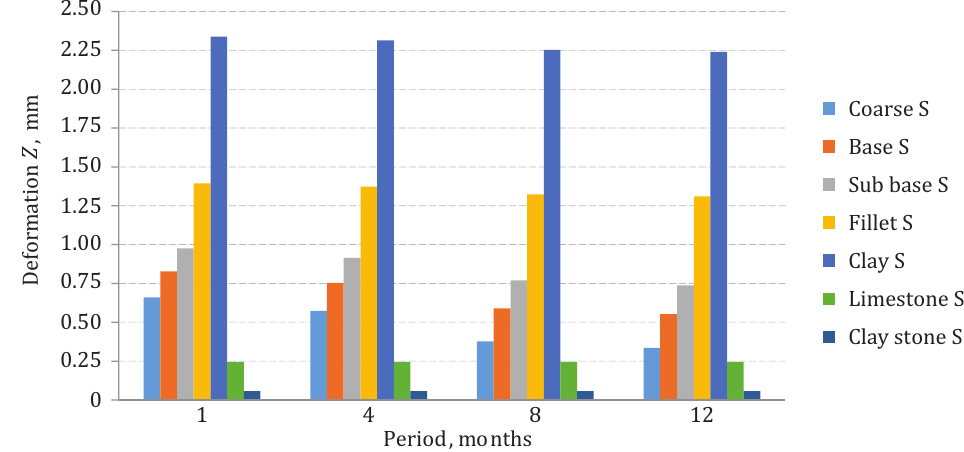
Figure 21. Lateral deformation ( z )-time changes of the layers for S